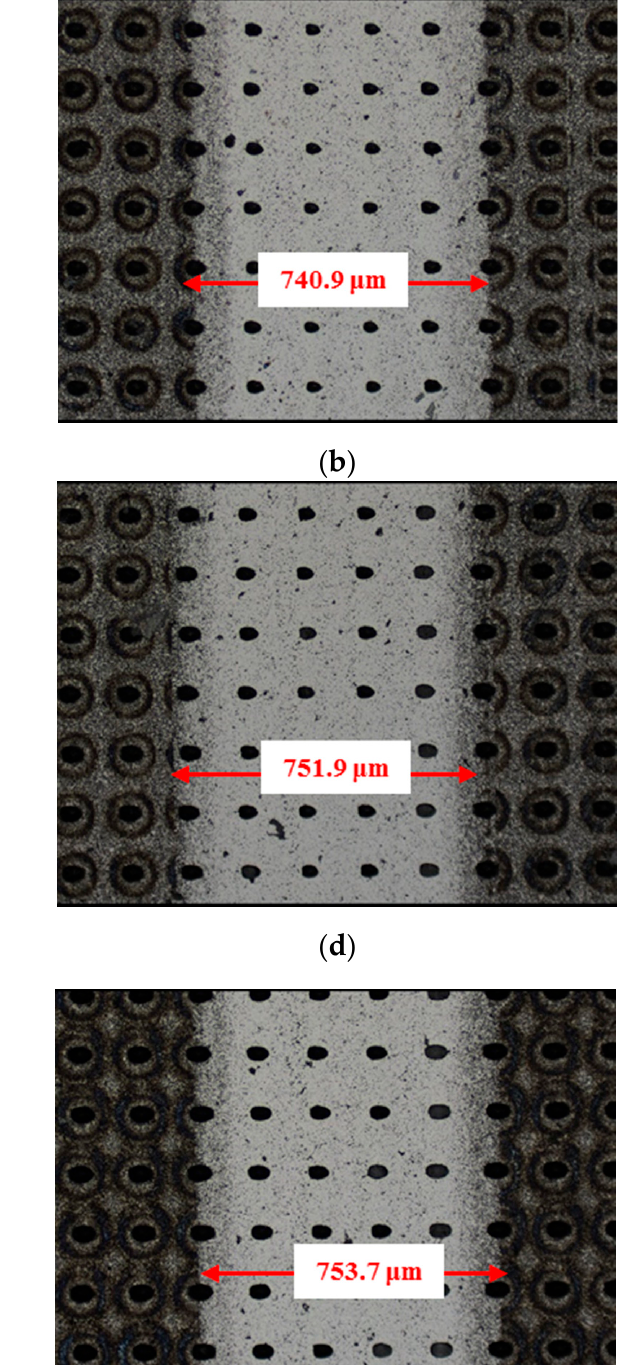
Figure 15. Wear performance of un-textured SiC under water-lubricated conditions with a load of 75 N (×10): ( a ) un- textured SiC–steel ball and ( b ) un-textured SiC–Si 3 N 4 ball.